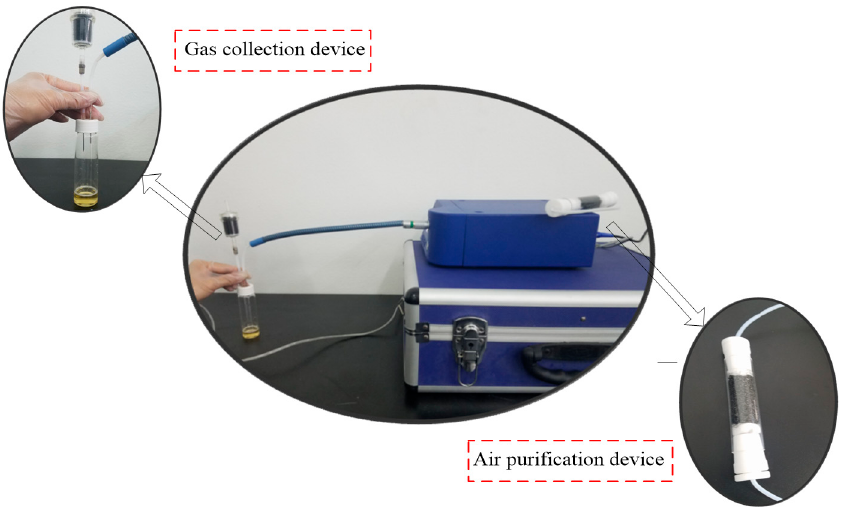
Figure 3. The PEN3 e-nose system.